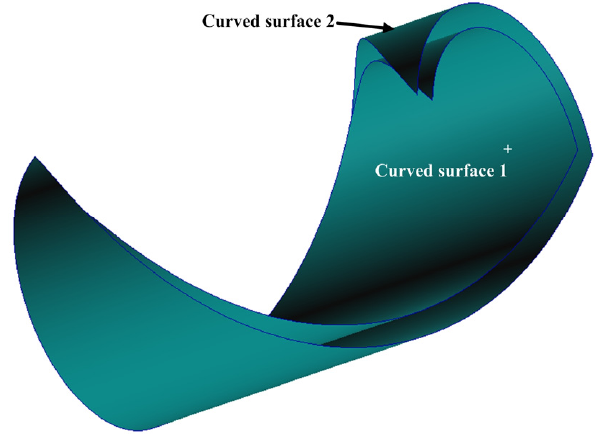
Figure 3. Leading lines and baselines.